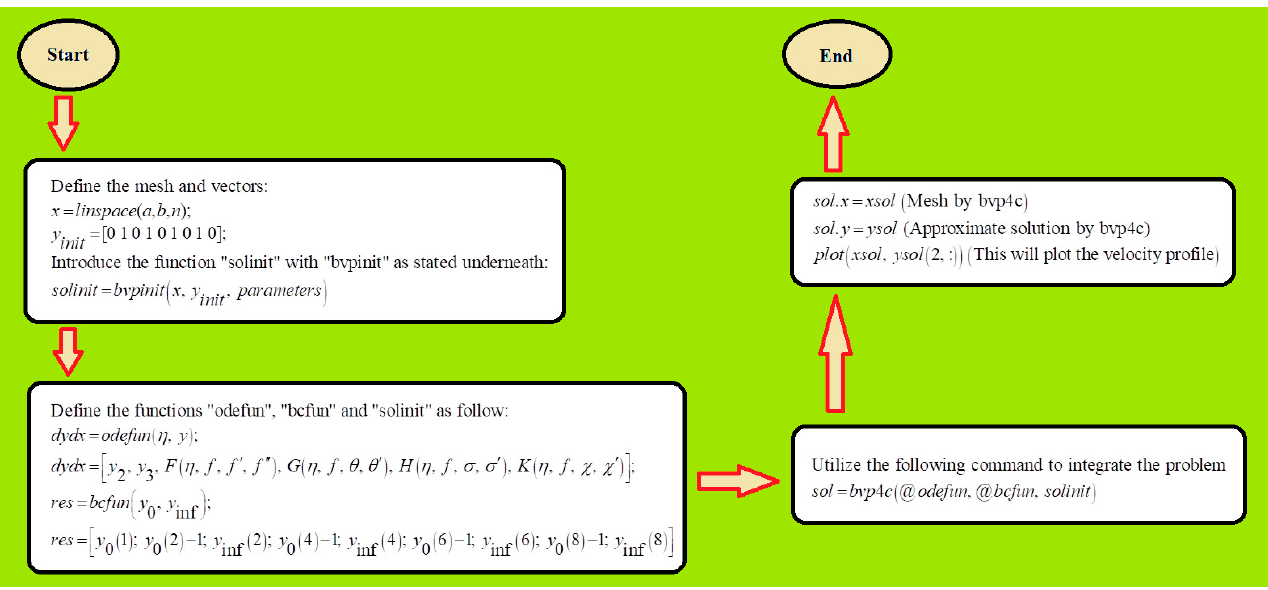
Figure 2. Flow chart of bvp4c scheme.